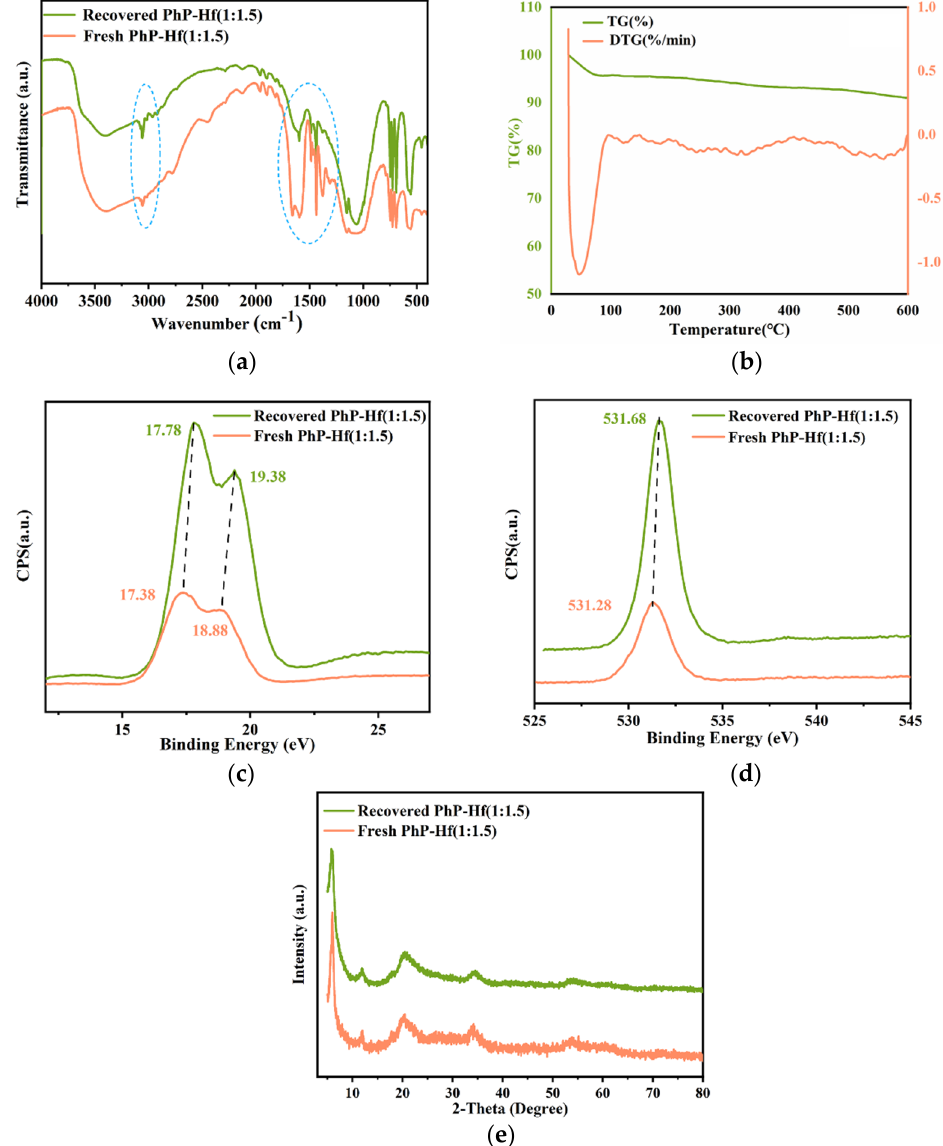
Figure 10. ( a ) FT-IR spectra; ( b ) TG-DTA curves; ( c ) XPS spectra of Hf 4f; ( d ) XPS spectra of O 1s; ( e ) XRD patterns of fresh and recovered (after 5 cycles) PhP-Hf (1:1.5) hybrids. Reaction conditions: 1 mmol 4-MOPP, 10 mL 2-pentanol, 0.1 g PhP-Hf (1:1.5) catalyst, 220 °C for 2 h.